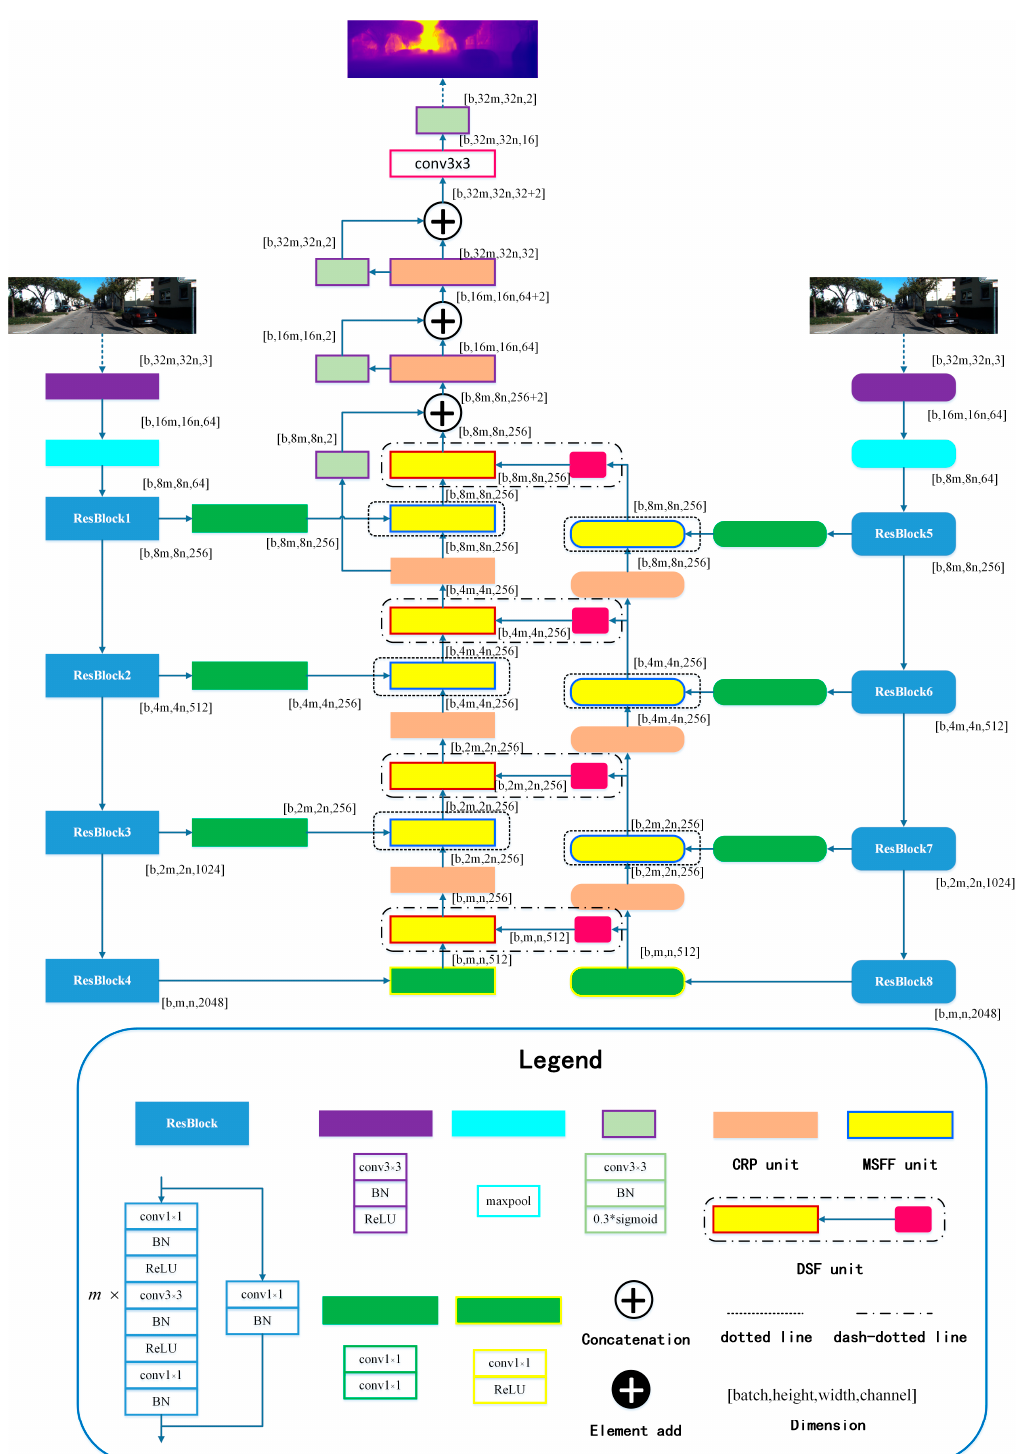
Figure 2. Our proposed architecture, named SFA-MDEN, exploits depth features and semantic features at different levels and fuses them to obtain a high-resolution monocular depth estimation. The square-corner rectangles denote the component modules of DepthNet, while the rounded rectangles denote the components of SemanticsNet. Structures of some components are illustrated in the form of a legend and some are shown in Figure 3. See text and Figure 3 for more